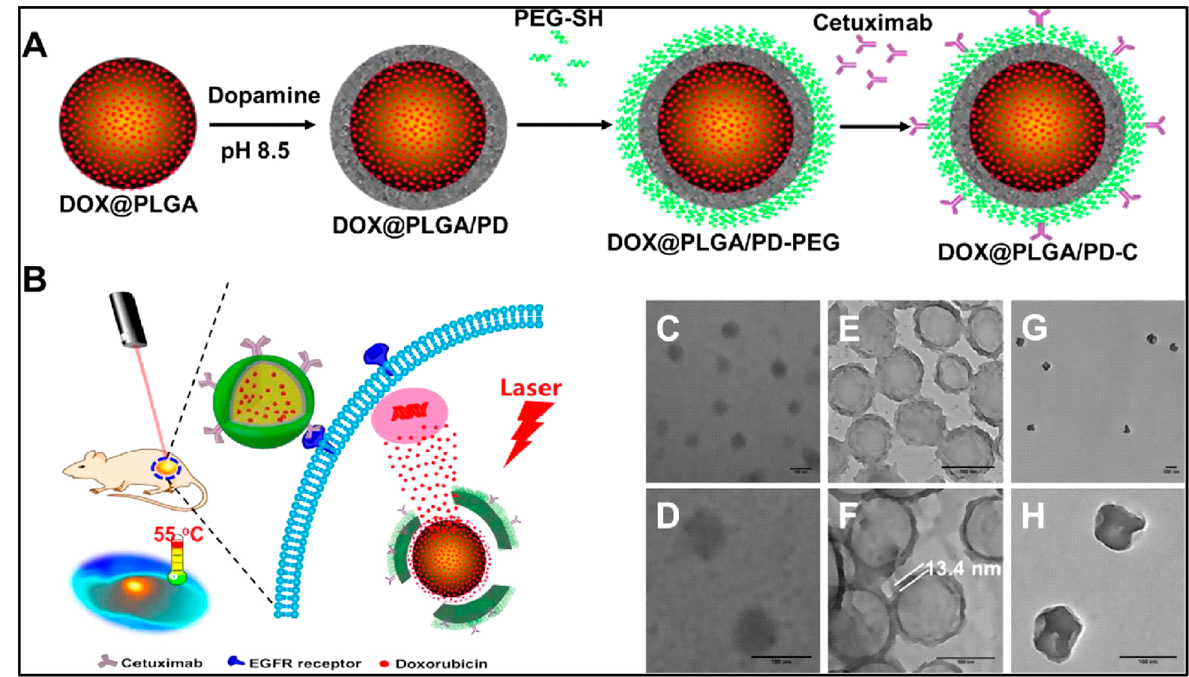
Figure 4. Schematic diagram for the preparation of an epidermal growth factor receptor targeted mussel inspired nanoparticle ( A ), and its proposed mechanism of action ( B ). TEM images of DOX@PLGA ( C , D ), DOX@PLGA/PD ( E , F ), and DOX@PLGA/PD after NIR irradiation ( G , H ). Scale bars are 100 nm in ( C – H ). Reproduced with permission from [12].